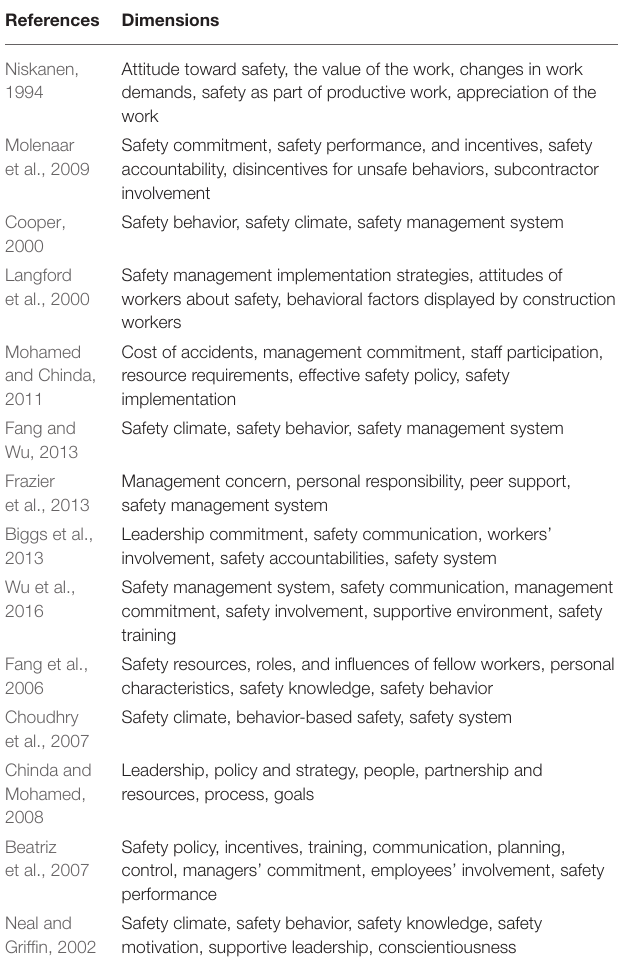
TABLE 1 | Different dimensions of construction safety culture. TABLE 2 | Dimensions and components of construction safety